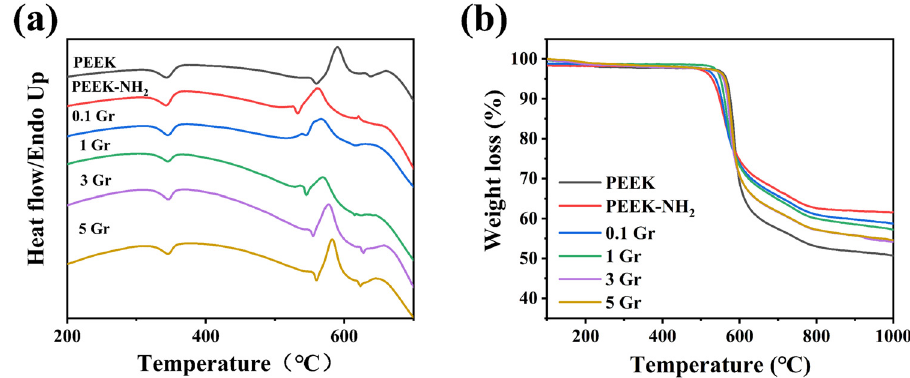
Figure 4: ( a ) DSC and ( b ) TG curves of PEEK, PEEK - NH 2 , and PEEK - NH 2 @Gr composite